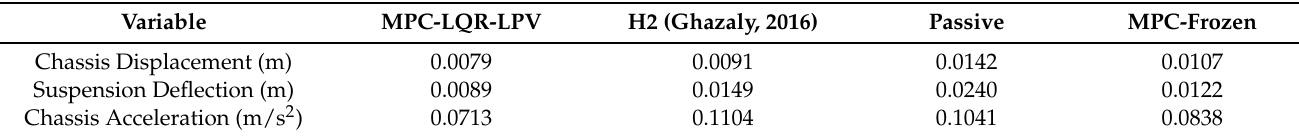
Table 2. RMS Values performance.